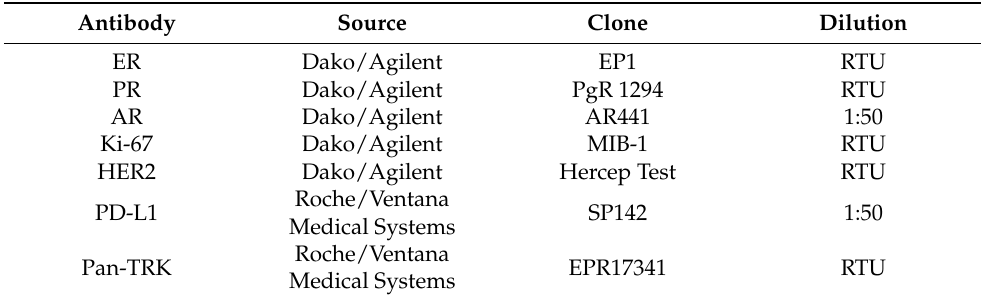
Table 2. Antibodies used for immunohistochemical analysis.